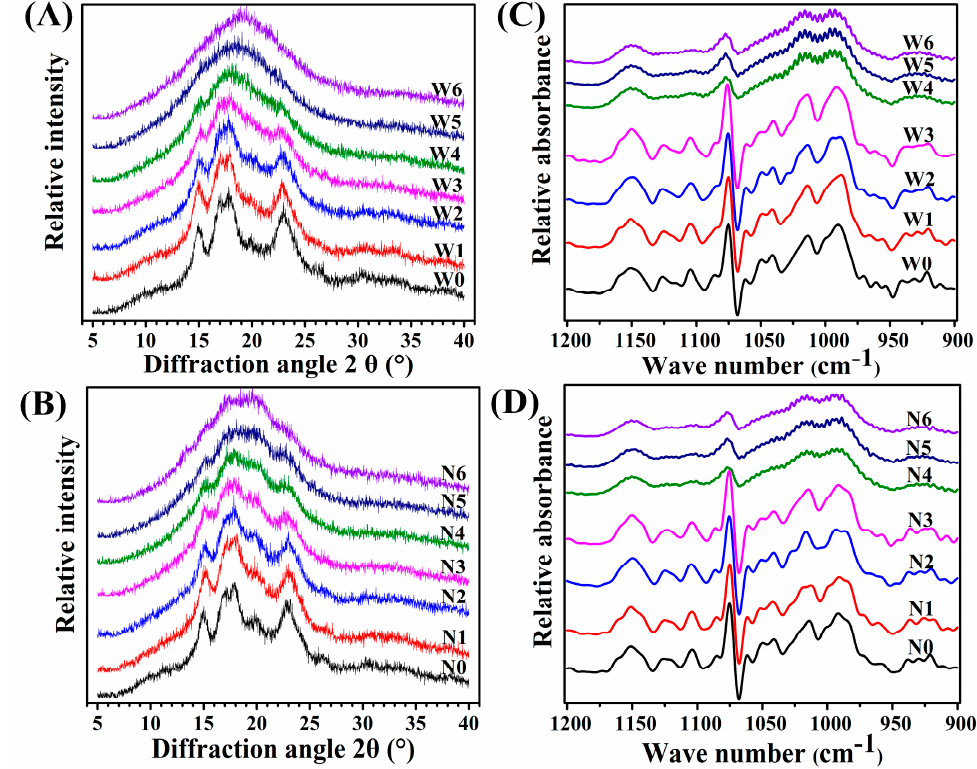
Figure 6. X-ray diffraction patterns (XRD) ( A, B ) and ordered structure (FTIR) ( C, D ) of uncooked and cooked proso millet flours. W0–W6: Uncooked and cooked (5, 10, 15, 20, 25, and 30 min) waxy proso millet flour, respectively; N0–N6: Uncooked and cooked (5, 10, 15, 20, 25, and 30 min) non-waxy proso millet, respectively.